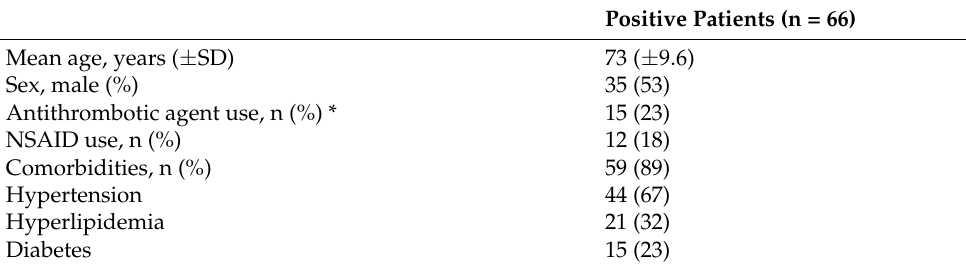
Table 1. Characteristics of fecal occult blood-positive patients.